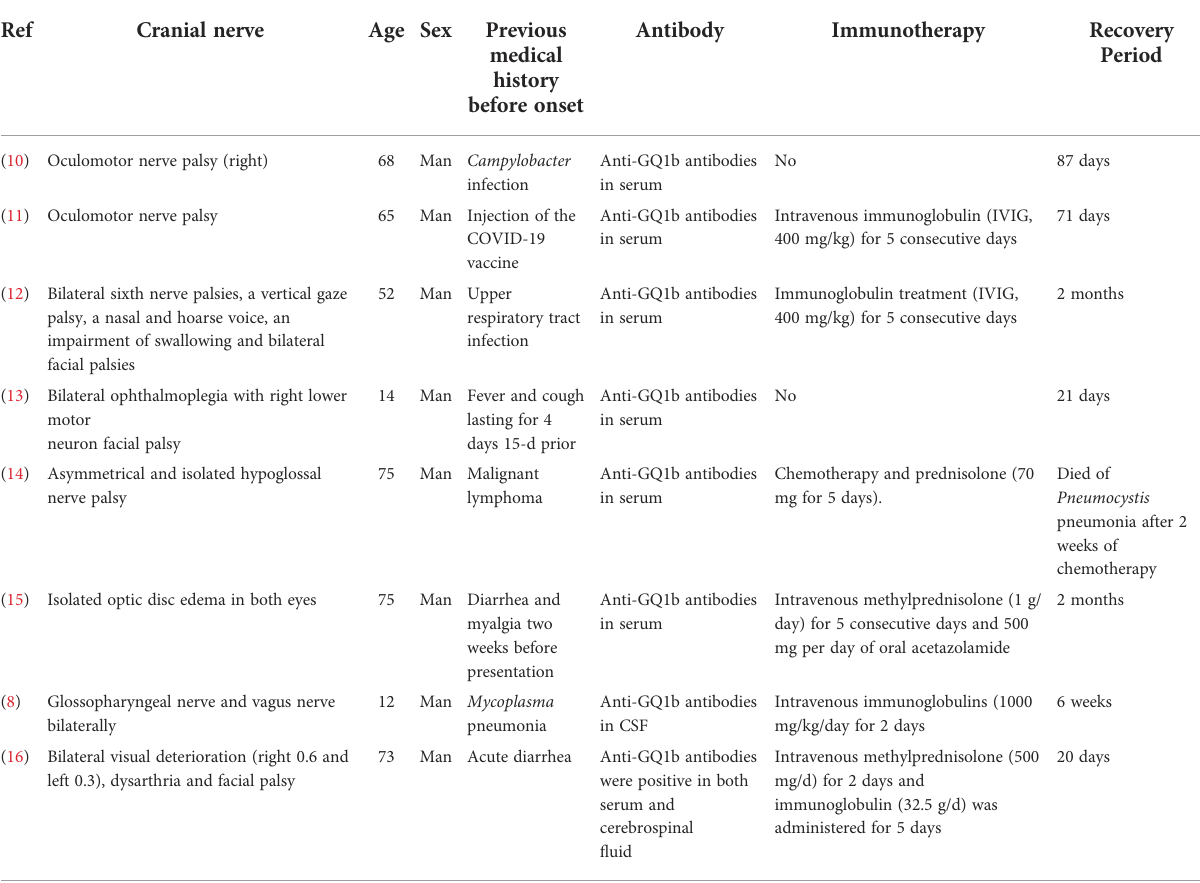
TABLE 1 Isolated cranial nerve damage reported in anti-GQ1b antibody